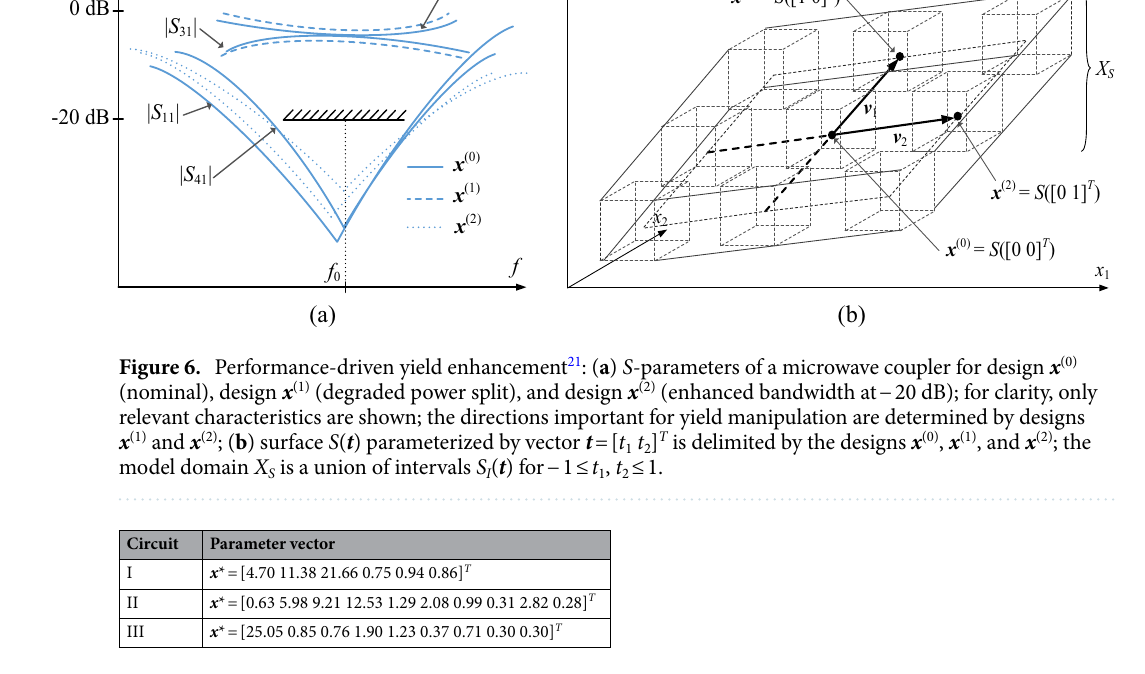
Table 3. Yield-optimized designs for Circuits I through III obtained using the proposed approach.